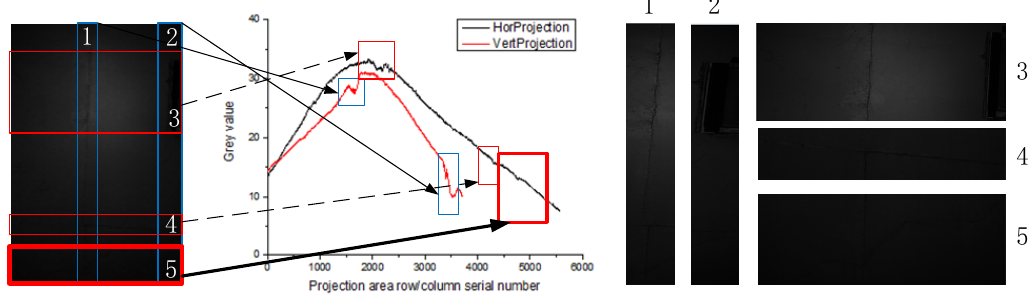
Figure 1. Tunnel lining image and its horizontal (vertical) gray projection curve. The gray value distribution of the image in Figure 1 is described by the black horizontal projection curve and the red vertical projection curve. Where, the horizontal axis of the horizontal (vertical) projection curve represents the column (row) serial number of the image, and the vertical axis represents the gray mean of the image counted by columns (rows). Therefore, the gray value of the vertical axis can reflect the brightness and darkness of the image, that is, the distribution of light. So, it can be seen that the overall image is dark, and the light distribution is uneven, and the middle is brighter than both sides. The lines of the image appear as abrupt changes in the projection curve.